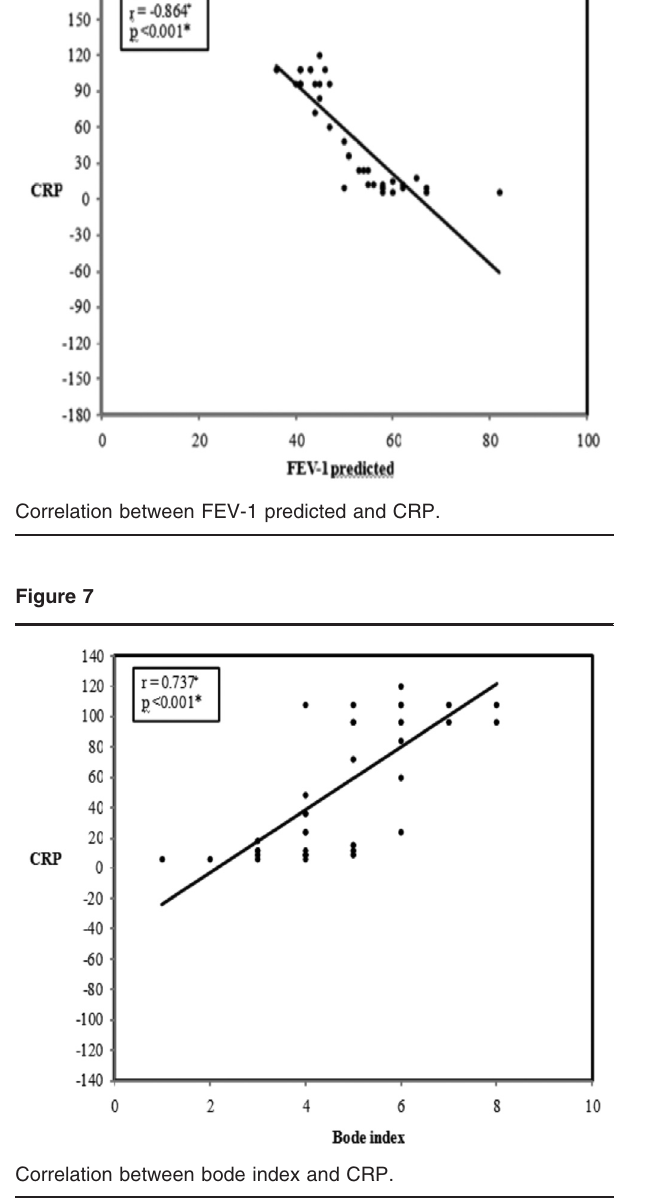
Correlation between bode index and CRP.